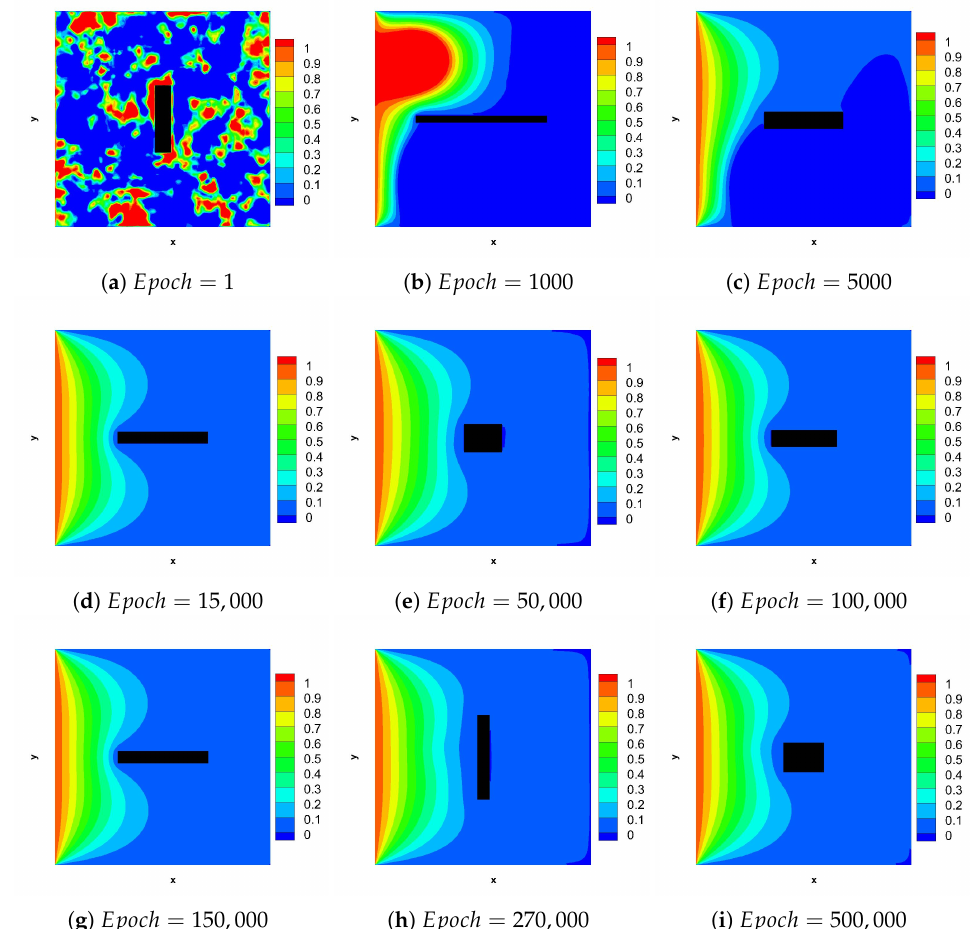
Figure 6. The training evolution of temperature field solution from epoch 0 to 500,000 for the single hole